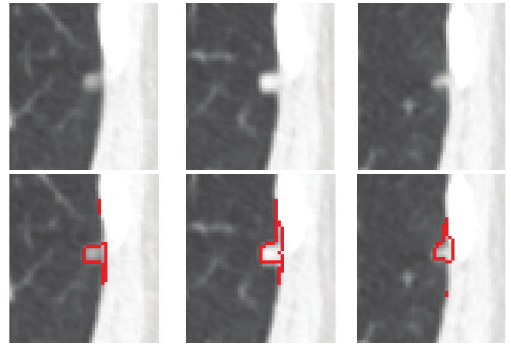
Figure 19: Another example of a pleural nodule segmentation. Top row: original 3D nodule on three contiguous slices; bottom row: segmentation results based on the proposed method in which the segmented nodule includes a small amount of lung wall.